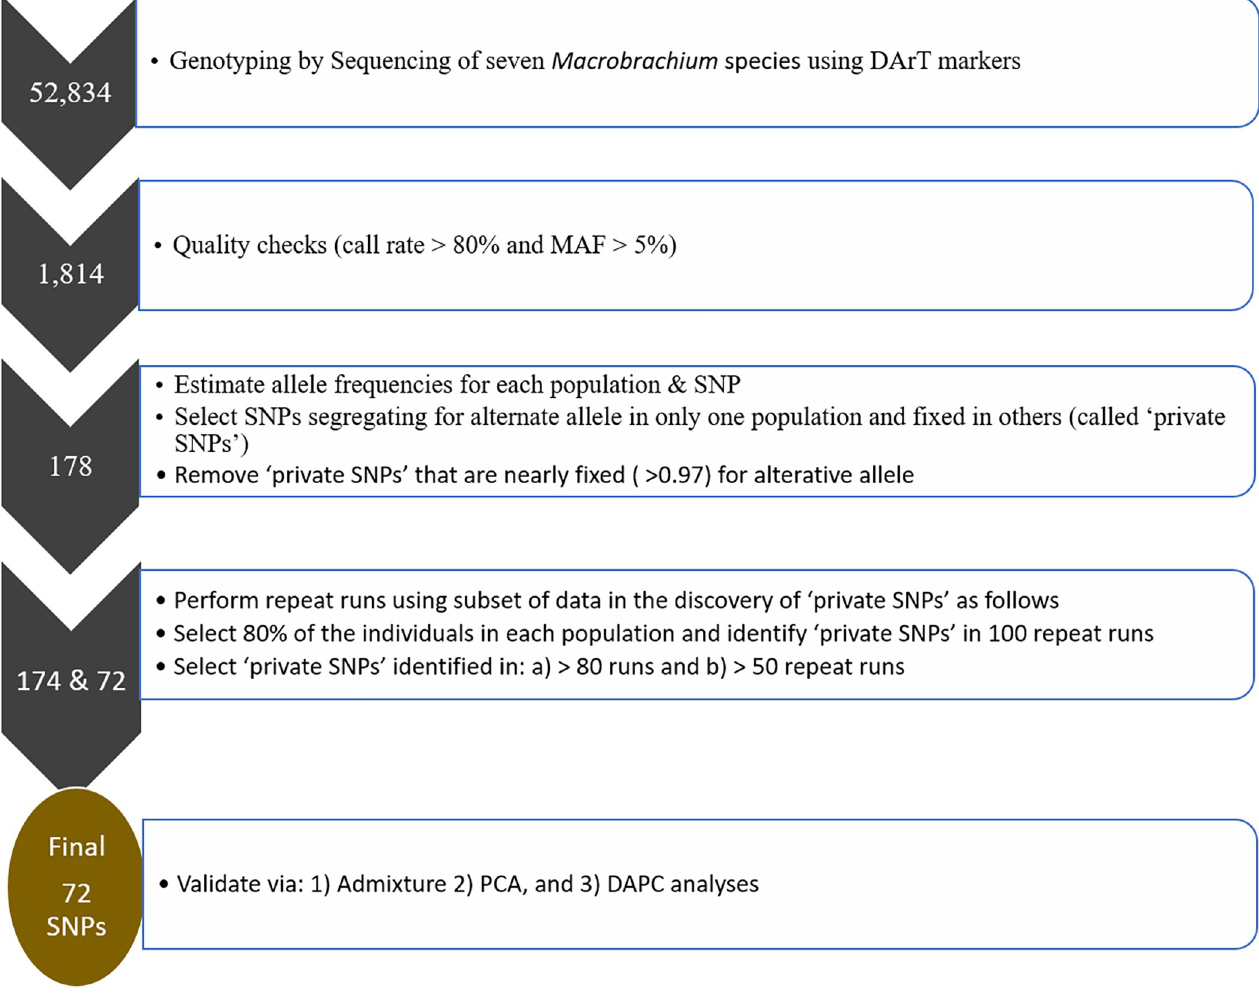
Fig 2. An overview of the identification and validation of ’private SNPs’ or informative SNPs. Step 1: a total of 52,834 SNPs were generated from genotyping by sequencing of Macrobrachium species. Step 2: the SNPs from ‘Step 1’ were screened for quality parameters leaving a total of 1,814 SNPs for further analysis. Step 3: the SNPs from ‘Step 2’ were used to prioritise 178 informative SNPs based on allele frequency estimates. Step 4: a total of 72 high- quality SNPs (‘private SNPs’) were selected from the 178 SNPs in ‘Step 3’ based on repeat resampling approach. Step 5: the SNPs from ‘Step 4’ were “validated” using three methods: a) PCA–principal component analysis; b) Admixture, and c) DAPC–discriminant analysis of principal components. MAF–minor allele